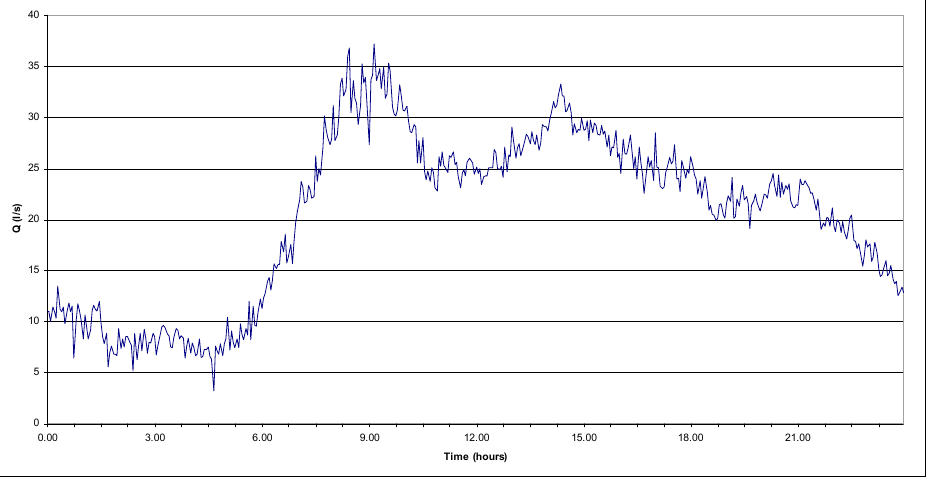
Figure 3. Example of daily water flow recorded during the measurement campaign (town: Crispiano).